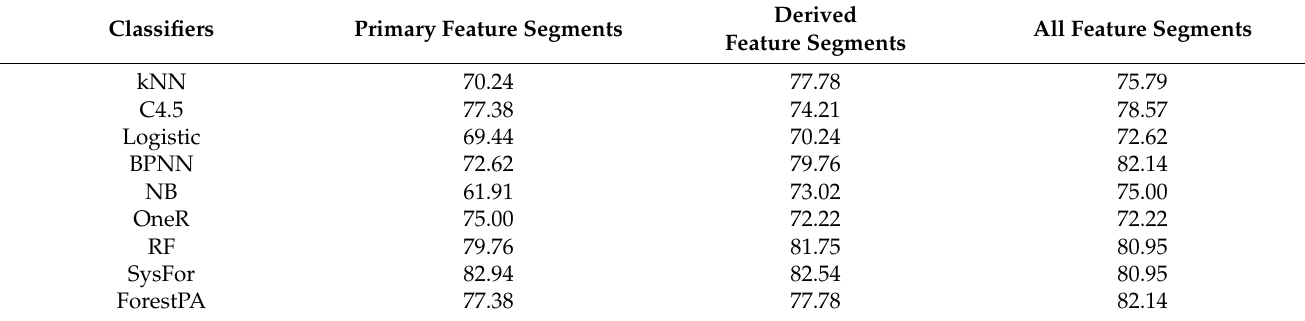
Table 3. The detection accuracy of supervised classifiers on primary and derived features of Istanbul acoustic